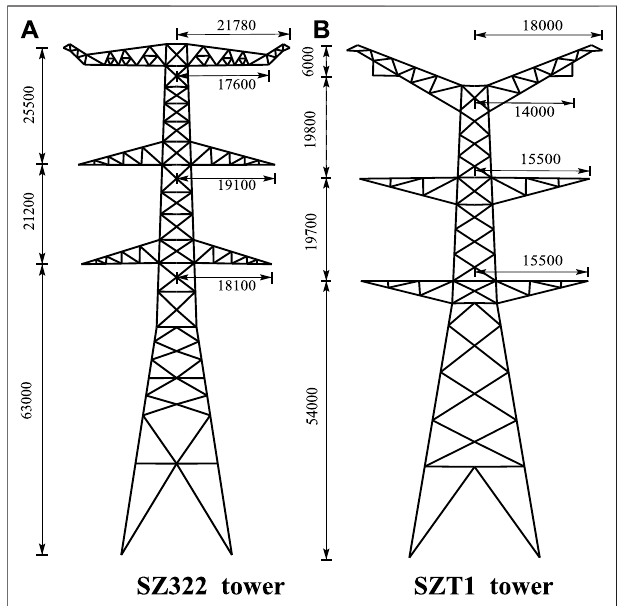
FIGURE 7 | Structure diagram of SZT1 and SZ322 double-circuit tower on the same tower. (A) SZ322 tower, (B) SZT1